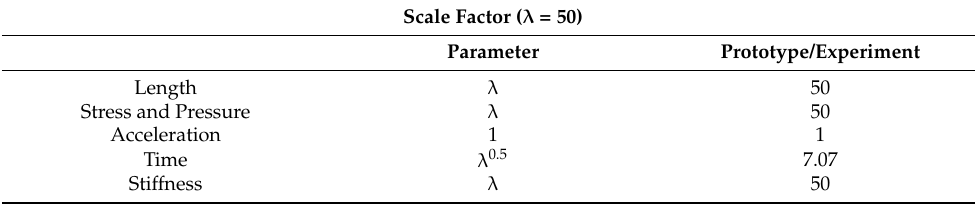
Table 3. Law of similitude based on Iai (1989).